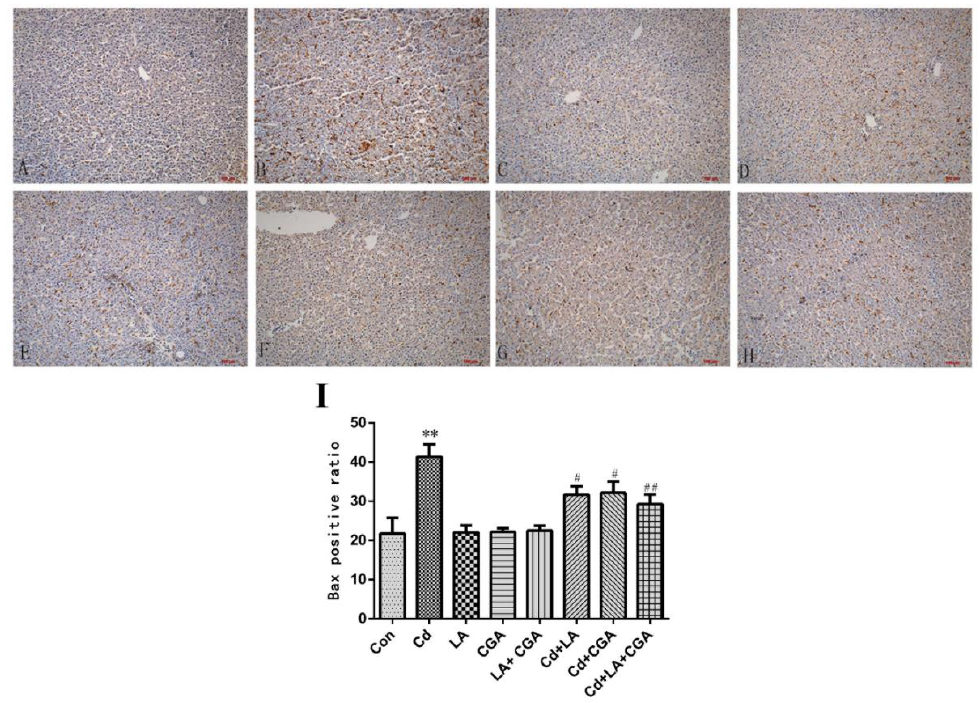
Figure 7. Effects of α -lipoic acid and chlorogenic acid on apoptosis protein Bax in cadmium-exposed chicken liver detected by immunohistochemical (200 × ). The photographs of immunohistochemistry— ( A ) control group; ( B ) Cd group; ( C ) α -LA group; ( D ) CGA group; ( E ) α -LA + CGA group; ( F ) Cd + α - LA group; ( G ) Cd + CGA group; ( H ) Cd + α -LA + CGA group. ( I ) The positive ratio of Bax in all groups. ** p < 0.01 vs. control, # p < 0.05, ## p < 0.01 compared to the Cd-treatment